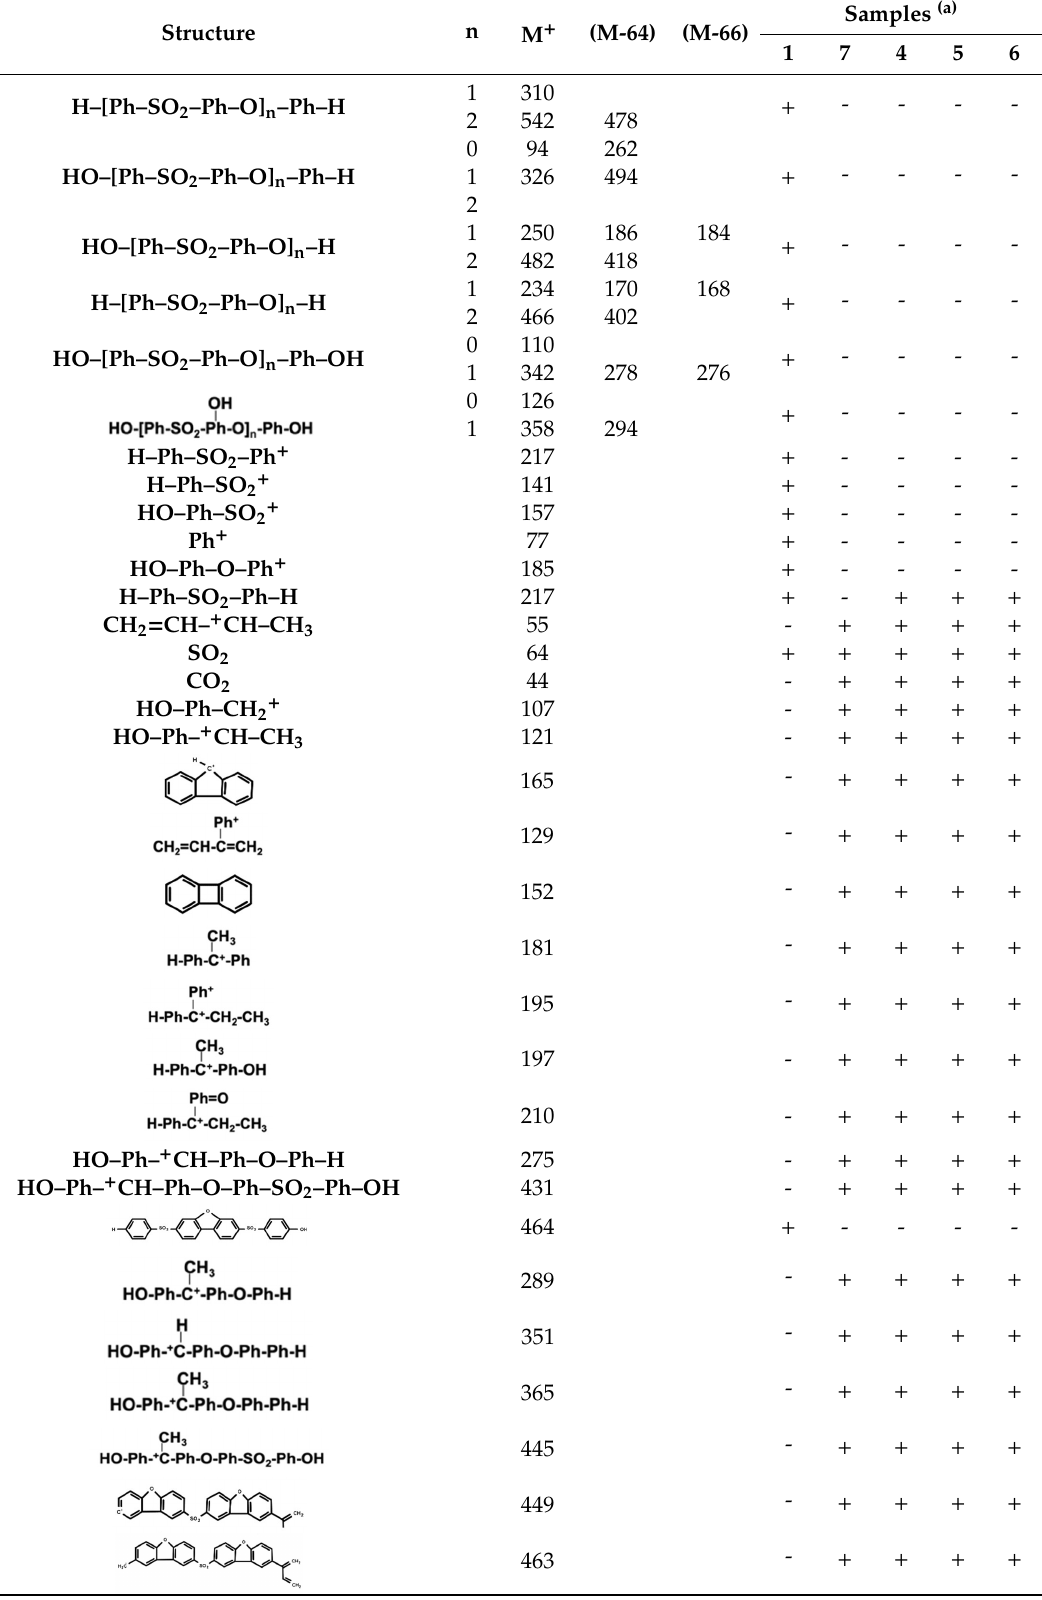
Table 2. Structural assignments of the molecular ions and fragments ions observed in the EI (70 eV) DPMS spectra.